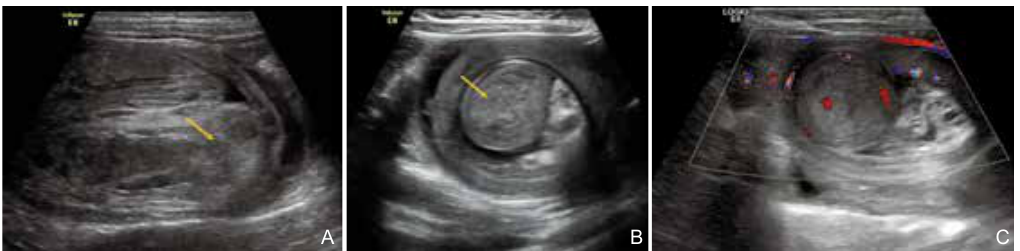
Figure 1 The ultrasonic examination of a 23-month-old girl showing SI to polyp which was confirmed through colonoscopy, and the intussusception was found in the left lower quadrant. (A) The short axis showing the “target sign”; (B) The long axis showing the “sleeve sign”, the neck of the intussusception showing hypoechoic masses with some honeycomb-like anechoic masses (arrow) in the ultrasonography; (C) Polyps (arrow) were found at the descending colon after water enema, and the polyps contained pedicles that were attached to the intestine wall; (D) CDFI shows the rich, branching blood flow signals.